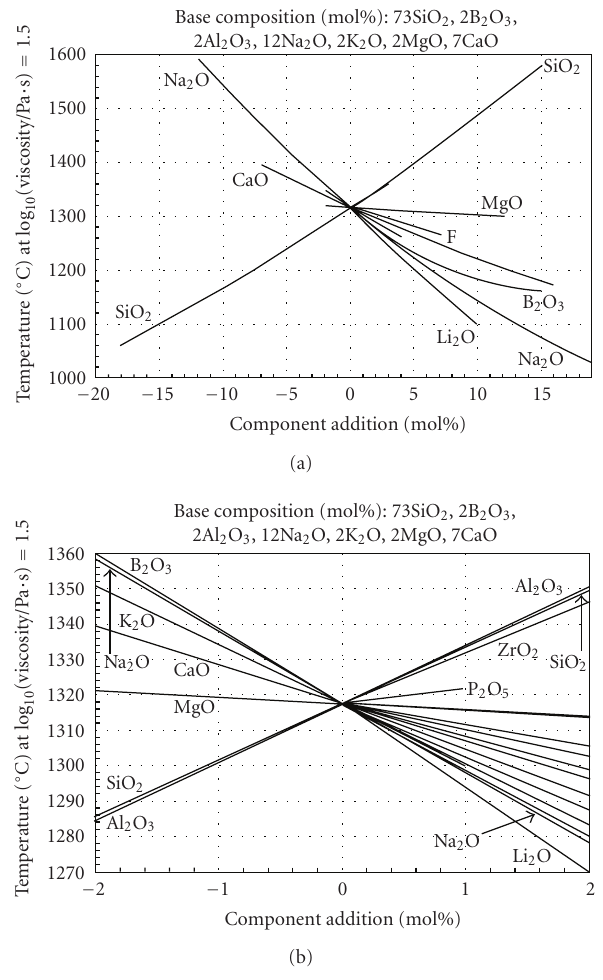
Figure 5: E ff ect of component addition on isokom log[ η ( T ) / Pa · s] = 1.5 [53]. Courtesy Alexander